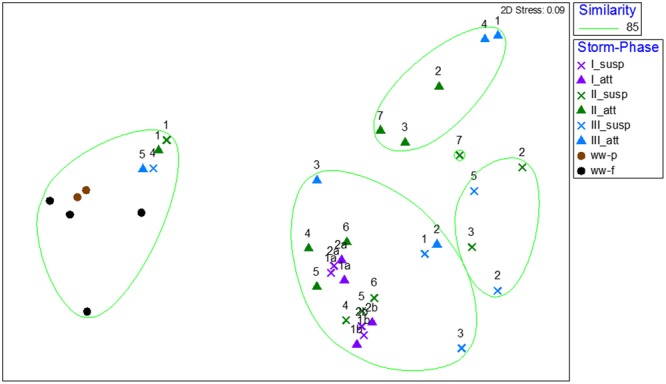
Non-metric multidimensional scaling analysis of bacterial community structures for wastewater influent concentrated by centrifugation (ww-p) or filtering (ww-p), and suspended (x) and attached (triangles) samples collected across three storms (I purple, II green, and III blue). The numbers above the storm sample symbols represent the order of samples (1 being the first sample collected, etc.). The overlay represents clusters with 85% similarity.